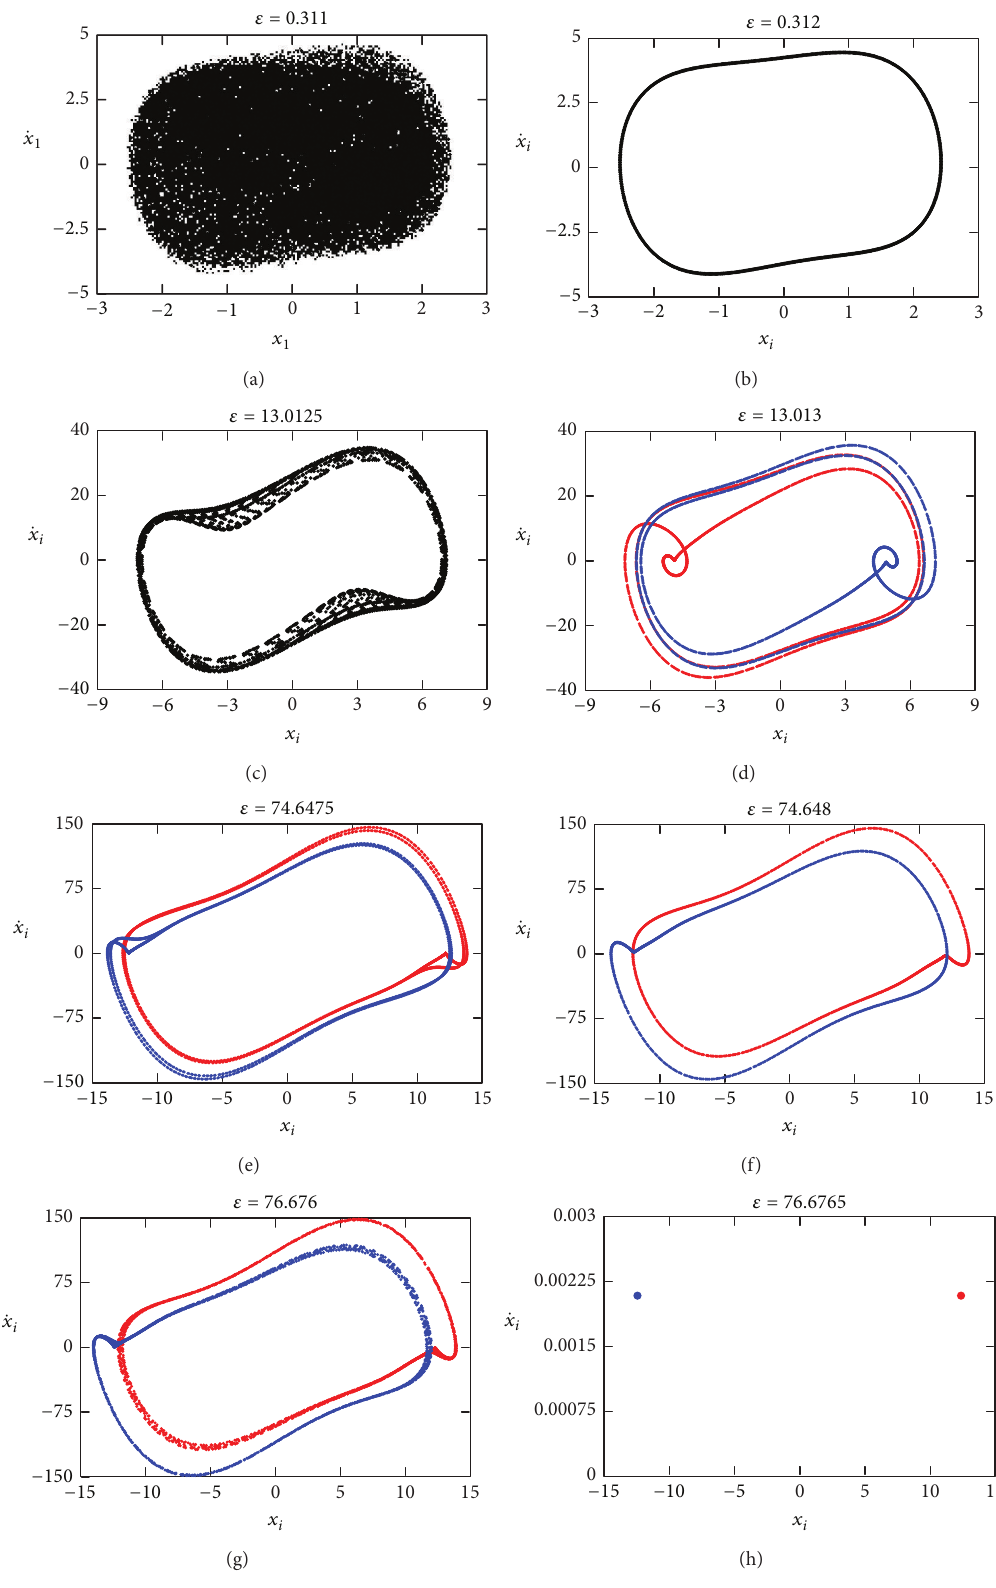
Figure 3: Poincar´e maps of the subsystems of (1). On (a), the map for 1st oscillator is presented. Maps (b)-(c) refer to all of the subsystems (maps overlap). Maps (d)–(h) also refer to all of the oscillators, but maps of the 1st, 3rd, 5th, 7th, and 9th oscillators are marked by blue colour while maps for the 2nd, 4th, 6th, 8th, and 10th by red